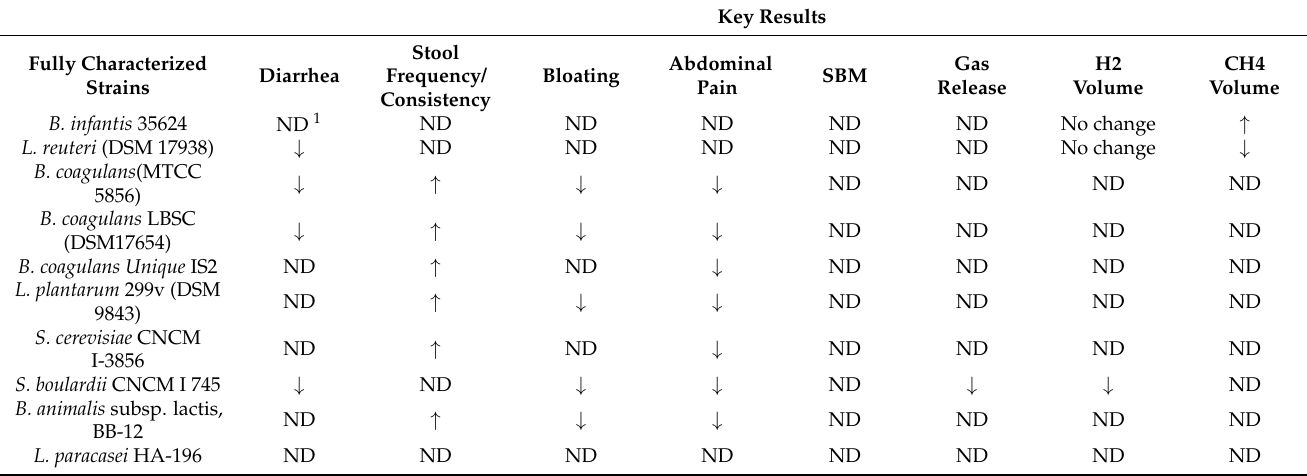
Table 3. Characteristics of included studies connected with